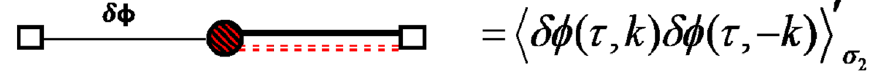
Fig. 6 In this diagram we show the leading order correction to the power spectrum from two-point function based on Eq. (13) for the massive field